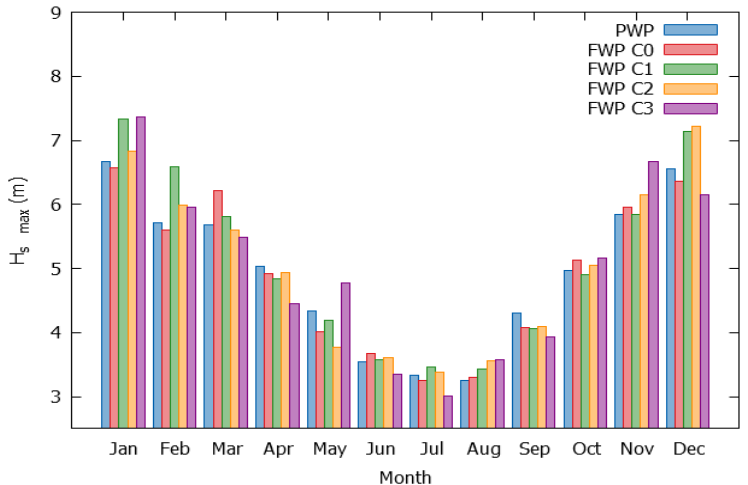
Figure 8. Comparison of the present (PWP) and future (FWP, clusters C0–C3) averaged monthly maximum storm wave height H s max at Pembroke.